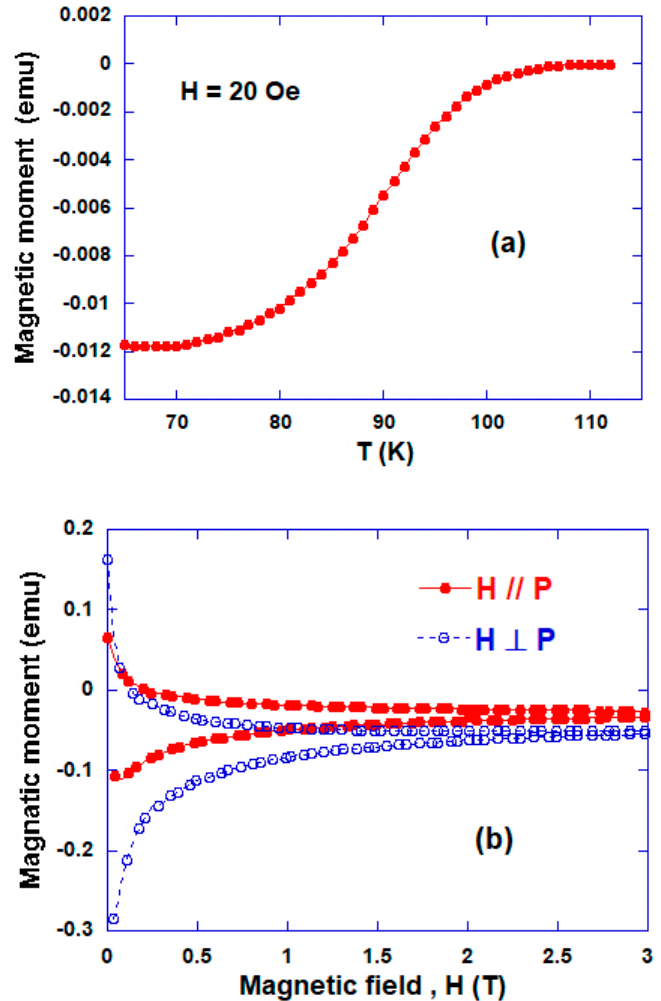
Figure 8. ( a ) Temperature dependence of magnetic moment. ( b ) Magnetization hysteresis cycles at 20 K with the measuring field H, parallel ( ο ) and perpendicular ( • ) to the pressure applied during processing.